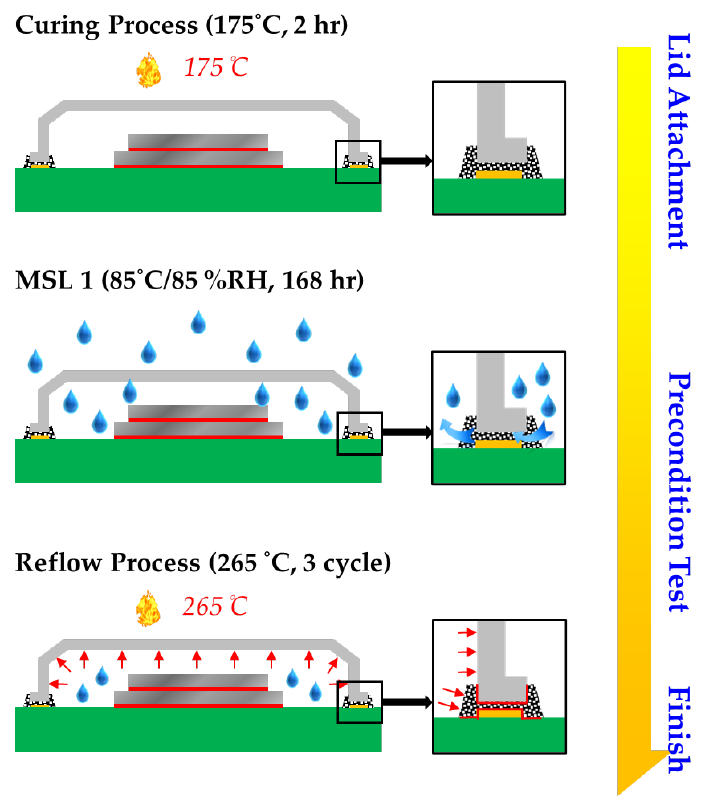
Figure 1. The fabrication process of MEMS package with metal lid.